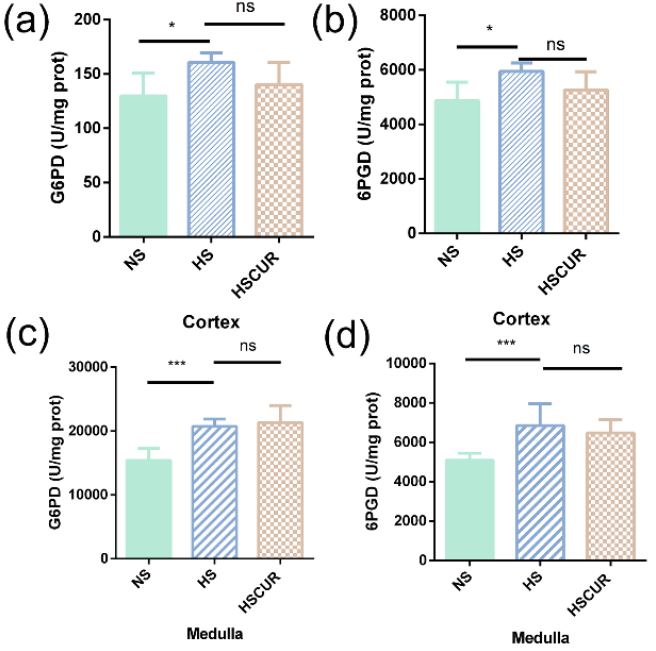
Figure 8. HSD induced a significant increase in glucose-6-phosphate dehydrogenase (G6PD) and 6-phosphogluconate dehydrogenase (6PGD) in the renal tissues. The activity of G6PD in the renal cortex ( a ) and medulla ( c ); the activity of 6PGD in the renal cortex ( b ) and medulla ( d ). ns denotes non significance, *** p < 0.001, * p < 0.05, and p -value was determined by one-way ANOVA test followed by Tukey’s test.